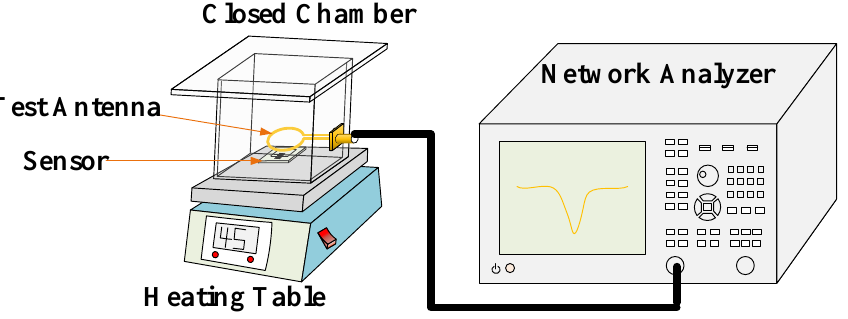
Figure 8. Schematic diagram of the test platform: It consists of a network analyzer, an external test antenna, a closed chamber and a heating station.